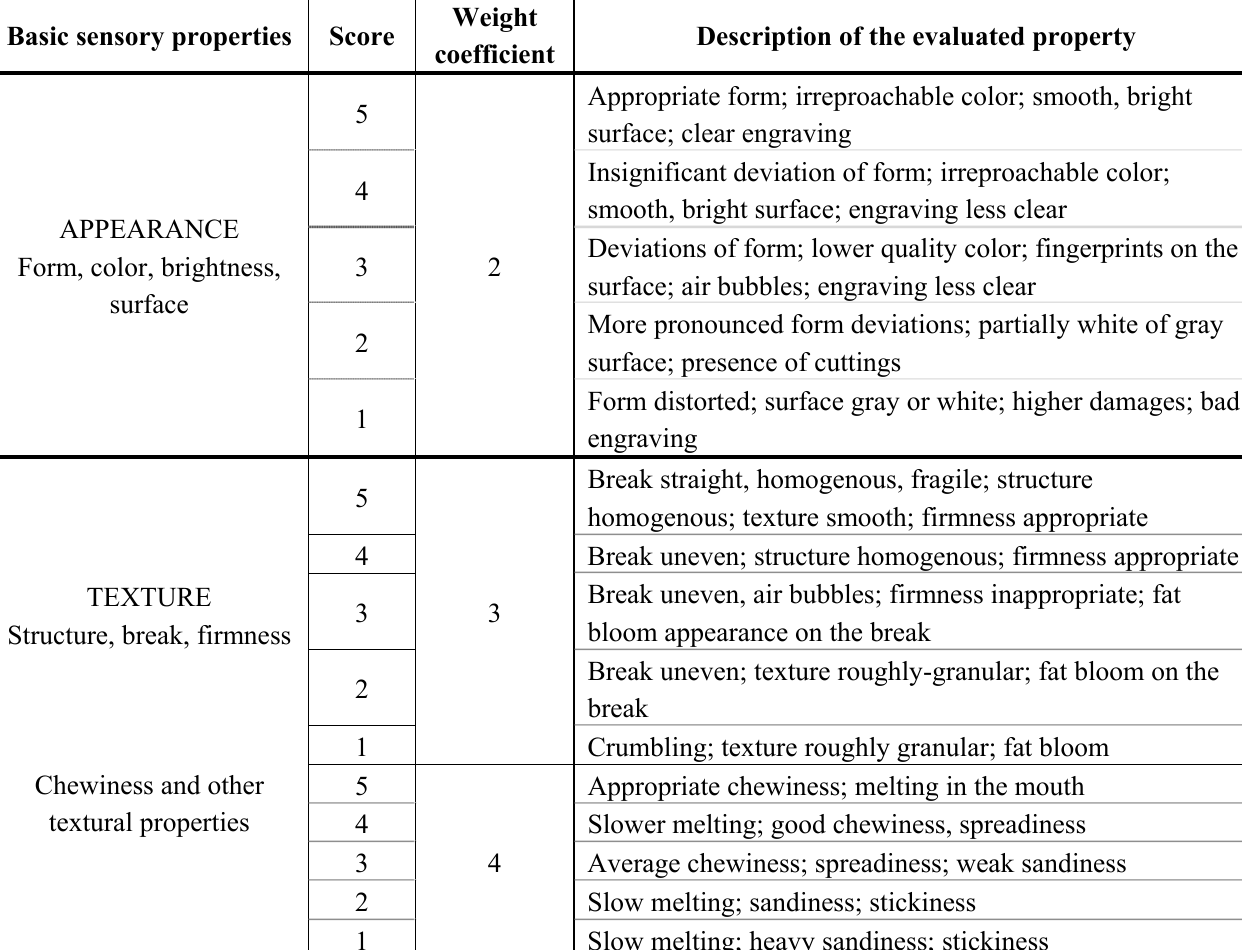
Table 1 . Sensory evaluation of the chocolate praline quality using the scoring